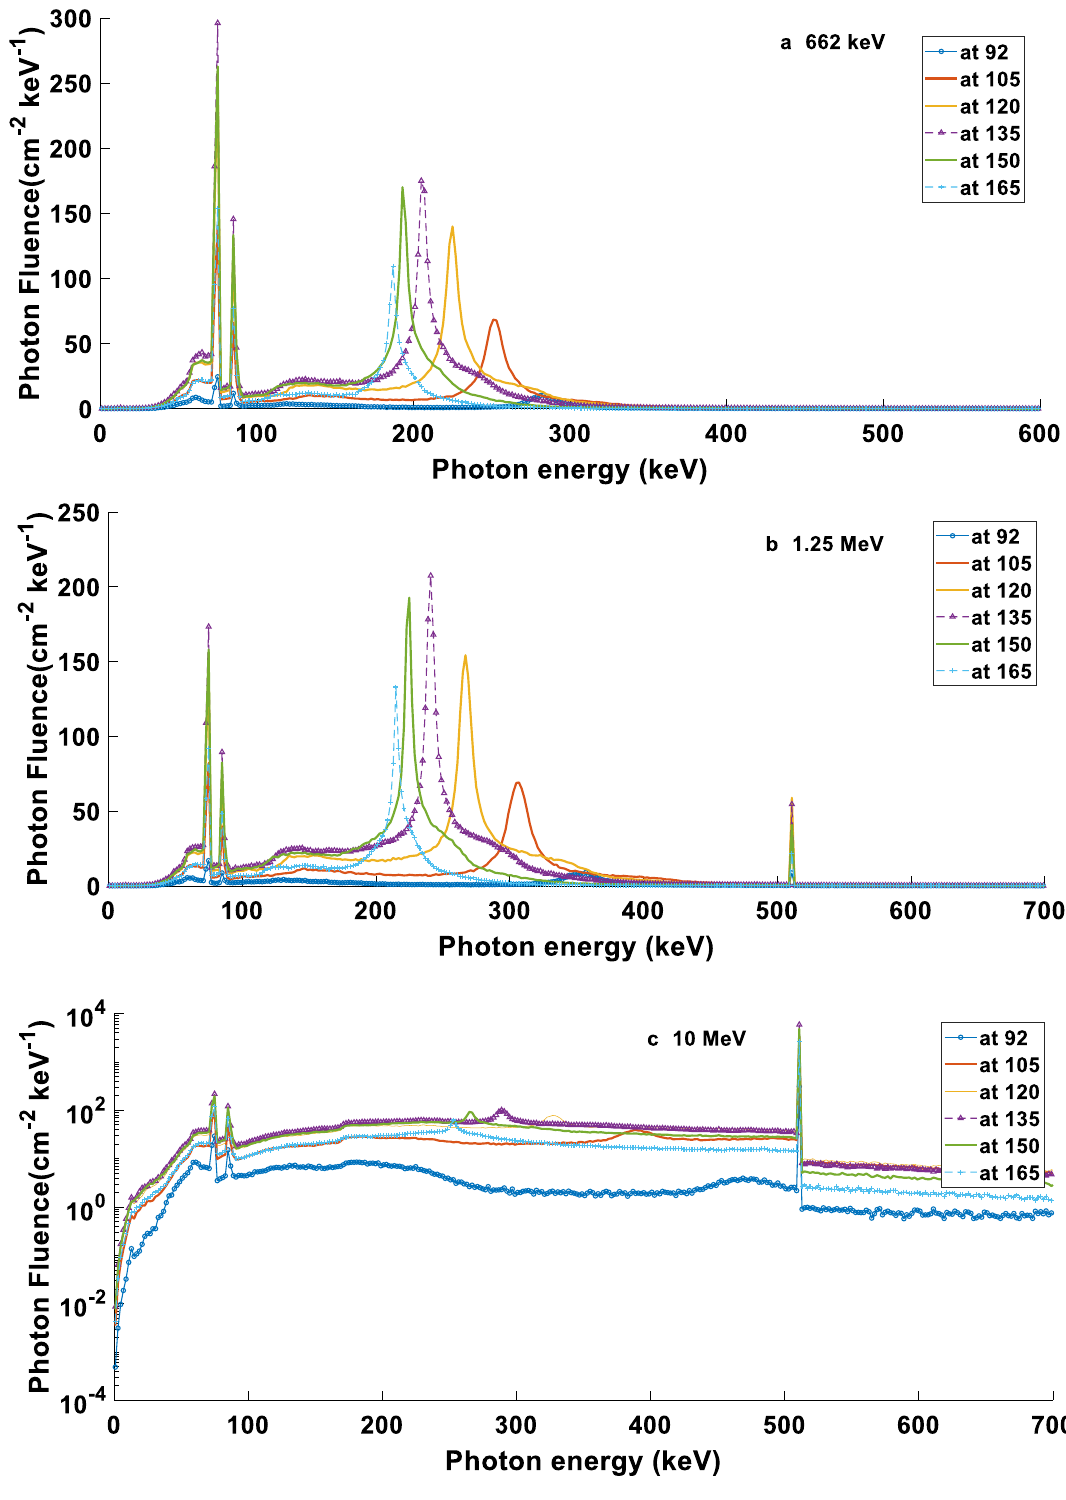
Figure 4. The fluence spectra of backscattered photons at various reflection angles of 2 mm Pb layered over ordinary concrete and incident photon energies of ( a ): 662 keV, ( b ): 1.25 MeV, and ( c ): 10